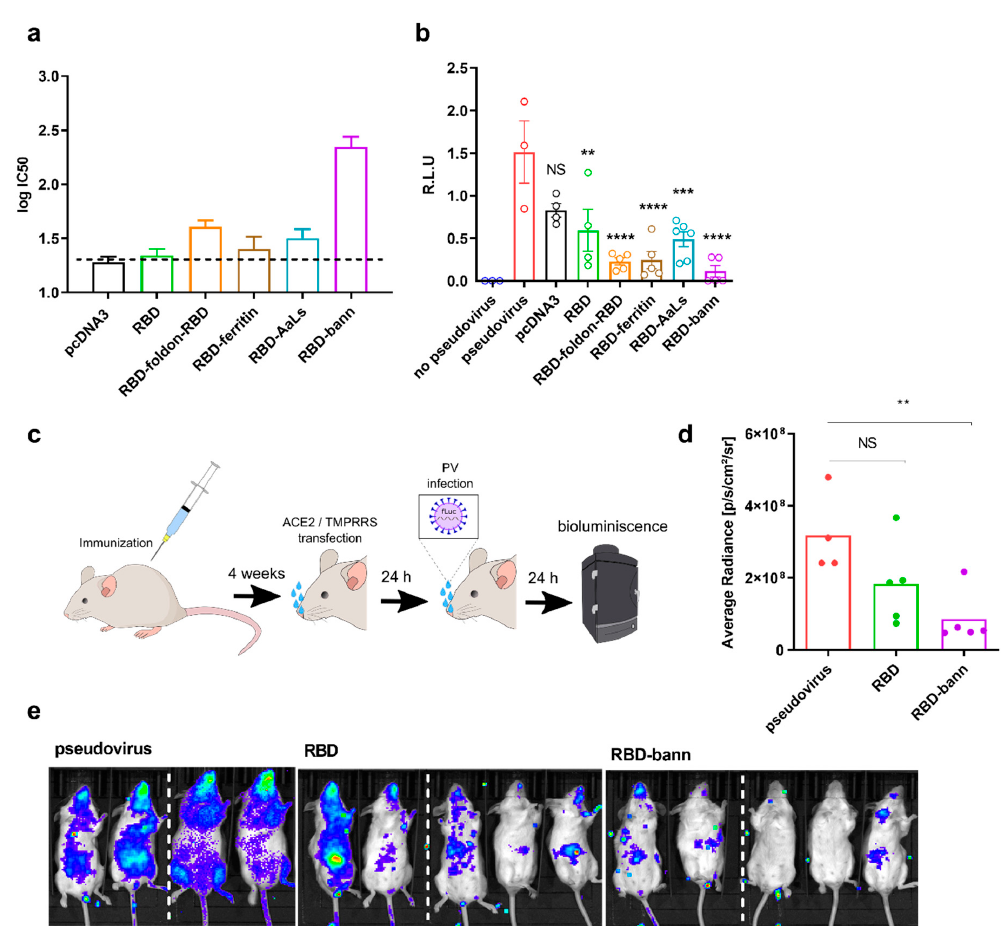
Figure 3. Neutralization of ACE2 binding and viral infection of RBD-scaffolded DNA vaccines. ( a – b ) Neutralization of the binding of the spike protein to the hACE2 receptor determined by an ELISA-type assay and inhibition of pseudoviral infection of cells by mouse antisera. Sera of mice immunized with DNA vaccines comprising different scaffolded RBDs were diluted and pre-incubated with a spike protein. Afterwards, Spike bound to ACE2 was detected using streptactin-HRP. The mean and SEM of six (RBD-AaLs) or five (all others) biological replicates are shown ( a ). Sera of mice immunized with DNA vaccines encoding scaffolded RBD were diluted 50-fold, and the spike-pseudotyped virus infection of ACE2 and TMPRSS2-transfected HEK293 cells was measured by luminescence. The mean and SEM of six (RBD-AaLs), five (RBD-bann, RBD-foldon-RBD, RBD-ferritin), or four (empty pcDNA3 vector, RBD) biological replicates are shown ( b ). ** p < 0.01, *** p < 0.001, **** p < 0.0001. All p values are from one-way ANOVA followed by Tukey’s multiple comparisons test. ( c – e ) Protection of infection by DNA plasmid immunization in a mouse model. Mice were immunized by two injections of different RBD plasmids separated by two weeks. After four weeks, hACE2 and TMPRRS were introduced by intranasal plasmid transfection followed by intranasal infection with SARS_CoV-2 S-typed virus (PV). Luminescence based on pseudovirus intranasal infection was measured after 24 h ( c ). Quantification of bioluminescence average radiance. Each dot represents an individual animal (pcDNA3 n = 4; RBD and RBD-bann n = 5). ** p < 0.01. All p values are from the Mann–Whitney test ( d ). Bioluminescence imaging revealing the protective state of immunized animals against pseudovirus infection in animals. The dashed line represents the merging of pictures of mice from the same test group taken separately ( e